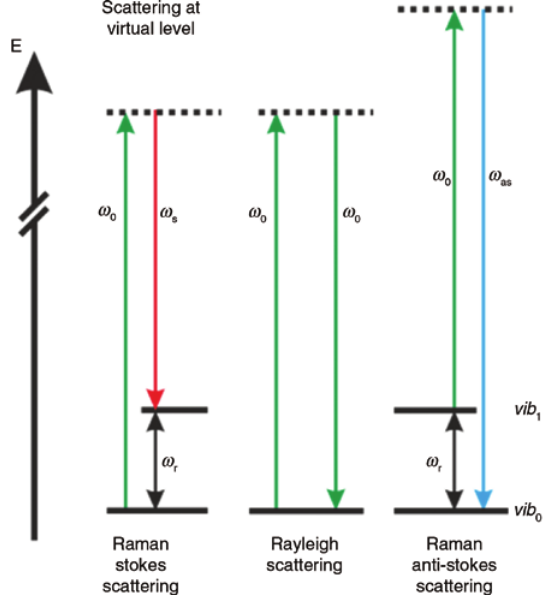
Figure 2: Energy level diagram displaying the principle of the Raman effect: incoming monochromatic light with frequency ω scattered either elastically (Rayleigh; ω transfer to (Raman Stokes scattering; ω scattering; ω ) the as